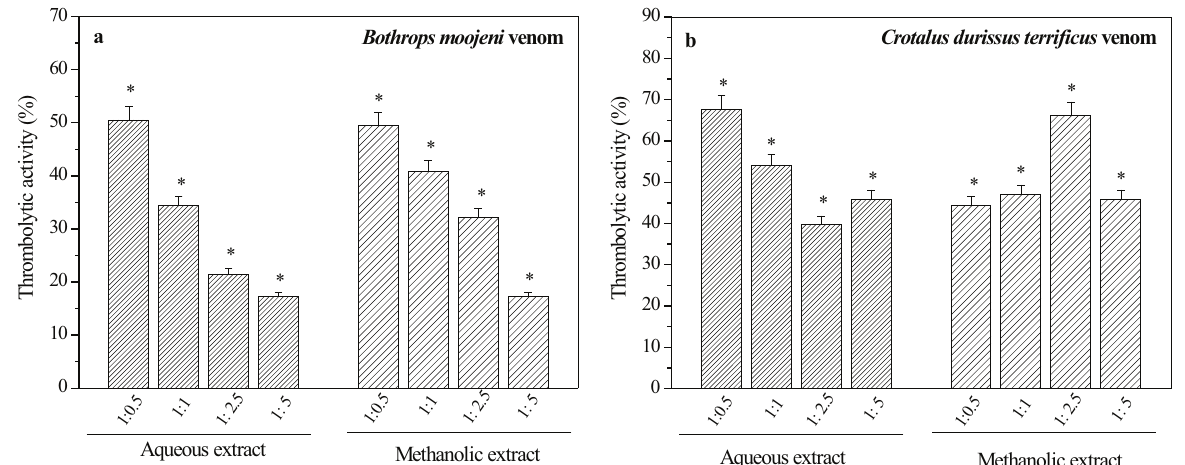
Figure 5 - Thrombolytic activity (%) induced by the venoms of snakes from the species: Bothrops moojeni ( a ) and Crotalus durissus terrificus ( b ) previously incubated with aqueous and methanolic extracts of jabuticaba skin. Controles (+) containing only venom (40 µg) was considered as having 100% of activity. The results correspond to the average of triplicates of the data obtained for each proportion (venom: extract, w:w) and the standard deviations. *the averages differ statistically from the respective positive control by the Dunnett test